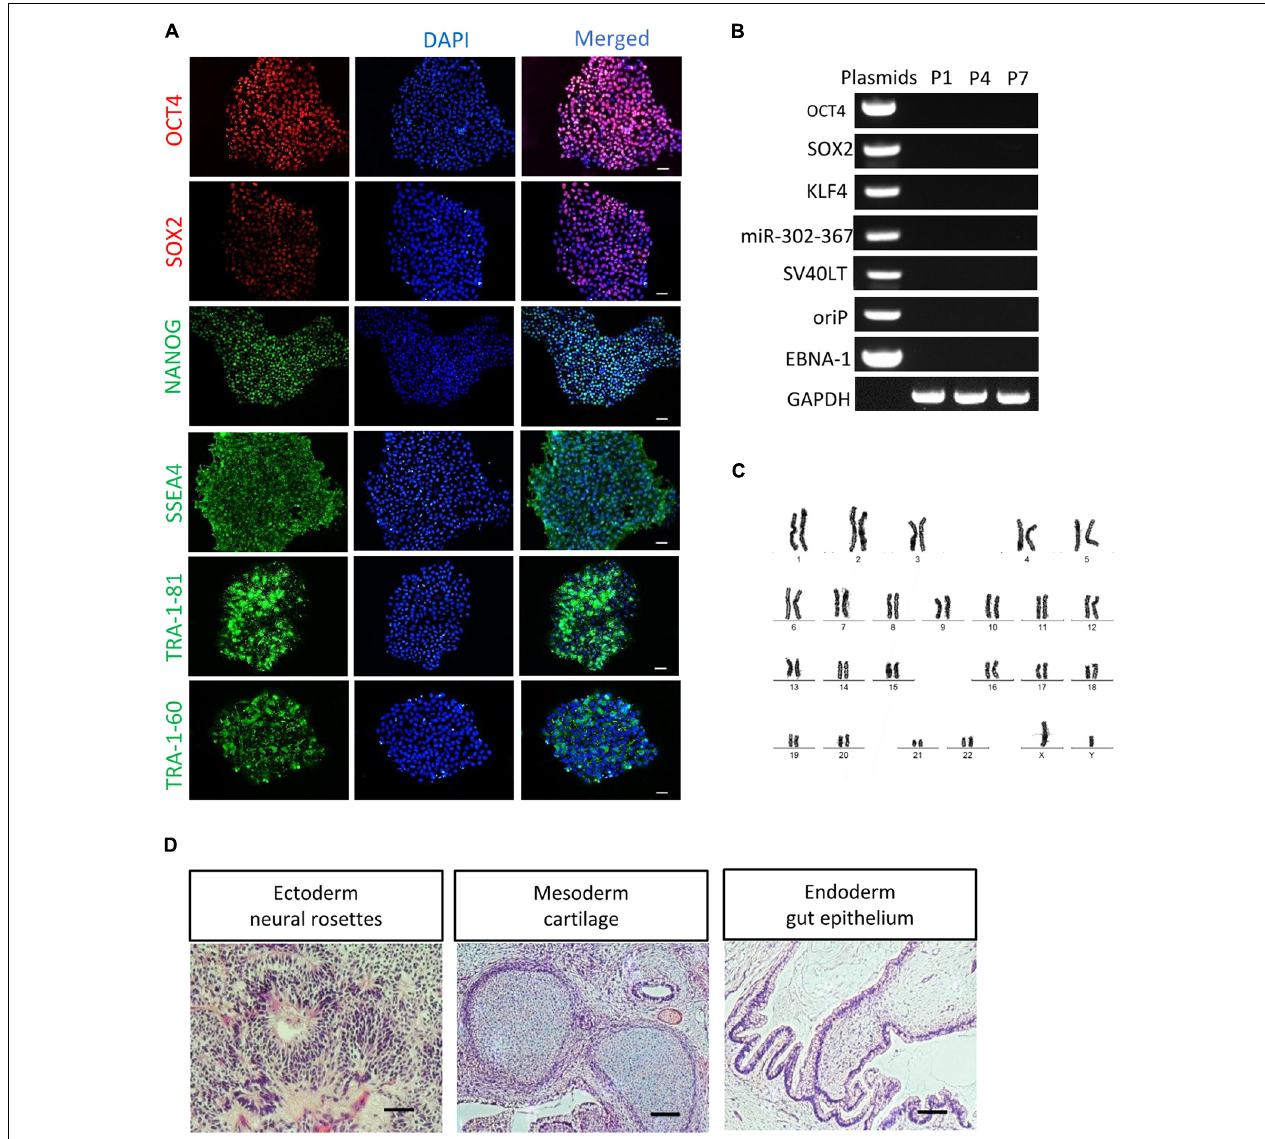
FIGURE 2 | Characterization of non-integrated RPE65-patient-specific hiPSCs. (A) Immunofluorescence staining of pluripotency markers (OCT4, SOX2, NANOG, SSEA4, TRA-1-81, and TRA-1-60) for RPE65-hiPSCs (C11–1, P5). Scale bars, 50 µ m. (B) Non-integrating analysis of episomal vectors in the RPE65-hiPSCs (C11–1, P1, P4, and P7) by RT-PCR. (C) G-band analysis showed that RPE65-hiPSCs (representative result of C11–1) had normal karyotype. (D) HE staining analysis of teratomas from RPE65-hiPSC in NOD-SCID mice. Scale bars, 100 µ